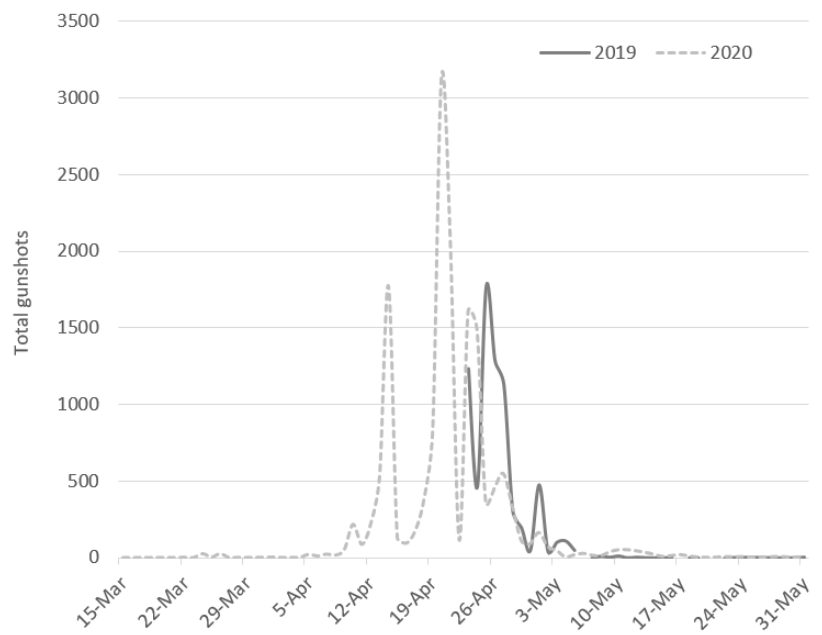
Figure 2. Daily variation in total poaching activity at the Keri and Vasilikos (Zakynthos Island) sites during the 2019 (23 April to 31 May) and 2020 (15 March to 31 May) spring migrations.